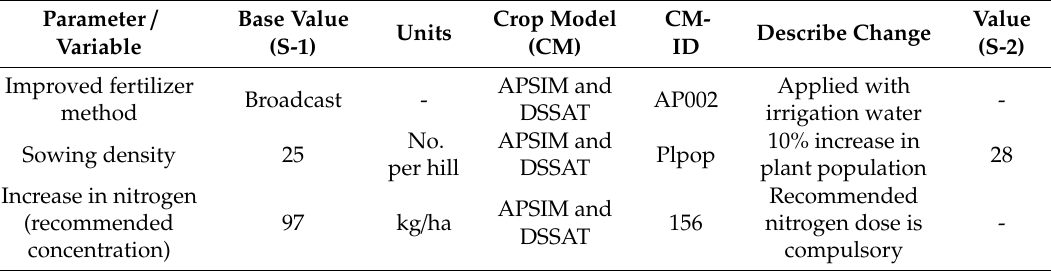
Table 2. Climate change adaptation package used for